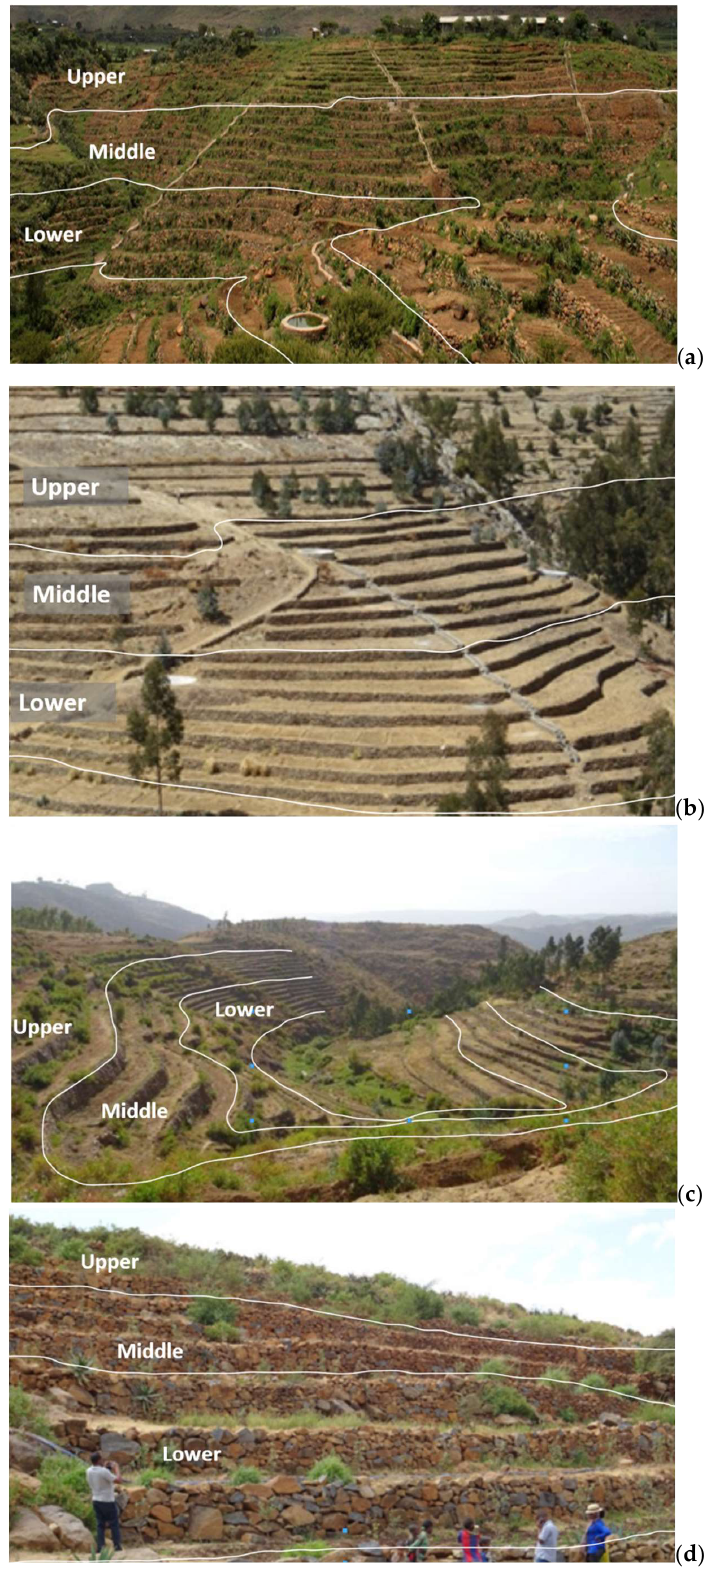
Figure 2. Location of soil sampling sites at the upper, middle, and lower positions of the four hillside farming sites: ( a ) Teshi, ( b ) Ruba Feleg, ( c ) Michael Emba, and ( d ) Enda Chena.